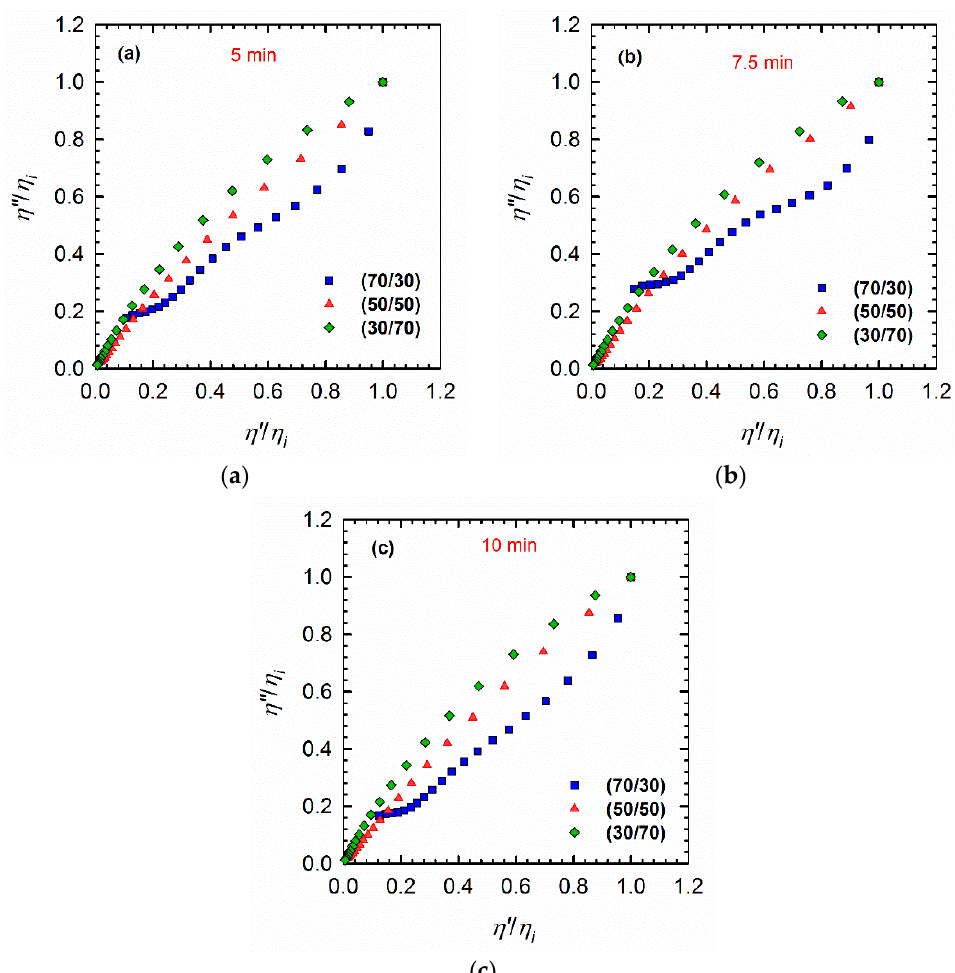
Figure 5. Cole–Cole plots of PLA/PVDF blends of different compositions processed for ( a ) 5 min, ( b ) 7.5 min, and ( c ) 10 min. The plots are normalized relative to the values of η ′ and η ″ of the respective initial viscosities η i .